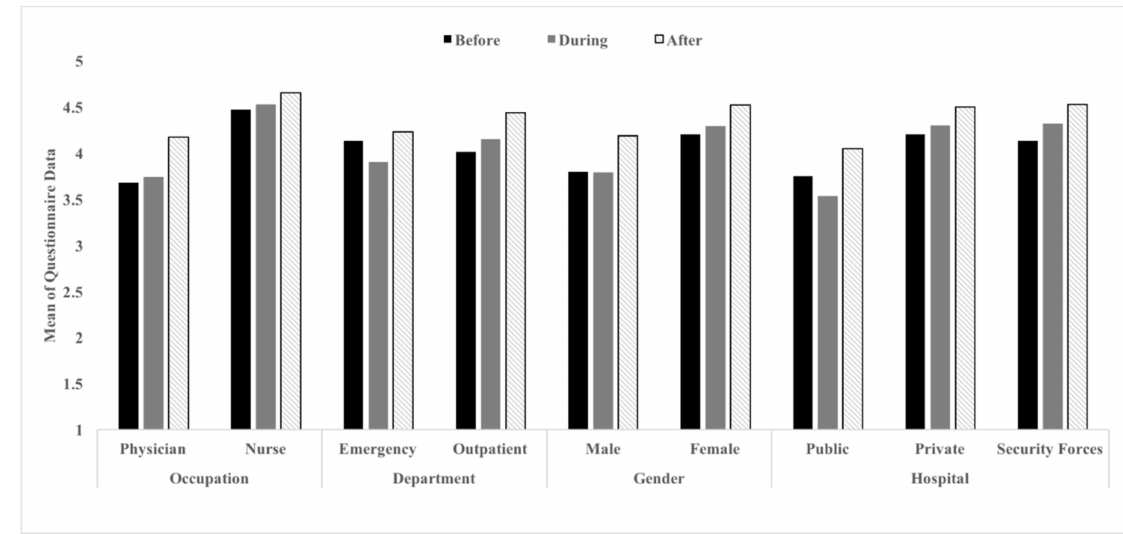
Figure 2. Comparing the means of all variables based on the questionnaire data. Note: Mean questionnaire scores range between 0 and 5, with 5 meaning compliance 100% of the